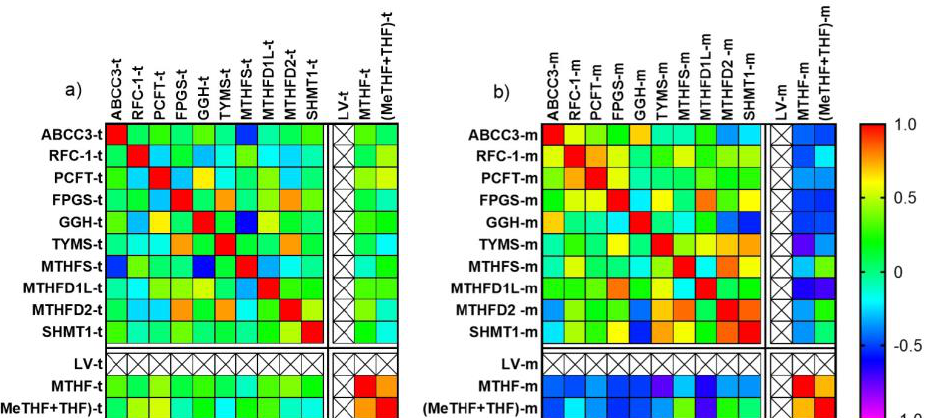
Figure 5. Heat maps showing the correlation between gene expression and folate levels in ( a ) tumors (t) and ( b ) mucosa (m) at baseline. The strongest positive correlation (1.0) is shown in red whereas the strongest negative correlation ( − 1.0) is shown in purple. LV in tissue was not analyzed at base- line.